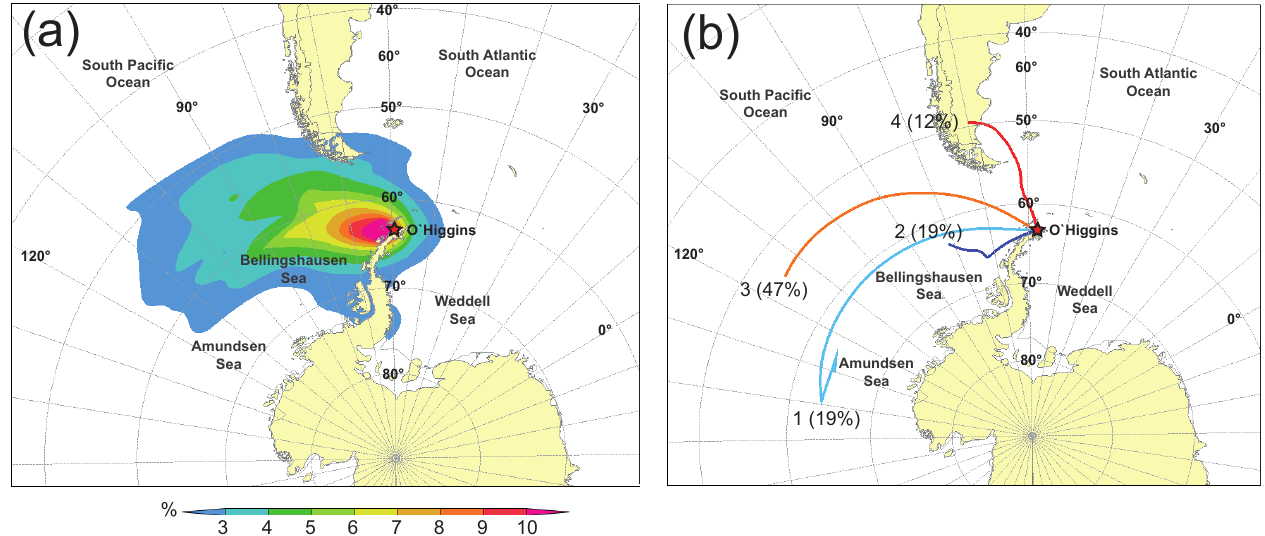
Fig. 16. Backward trajectories analysis (3-days): (a) Frequency of track of the single trajectories calculation of air parcels arriving at OH station (1500m a.s.l. level) during precipitation events. A total of 139 single trajectories were calculated and (b) backward trajectories clustering for precipitation events at OH station. Four main clusters are identified, the percentage of trajectories bundled to each cluster is stated in parenthesis (cf. Table 6). From a total of 139 trajectories, 4 events are not associated to any of the clusters. The red star shows the location of O’Higgins Station.